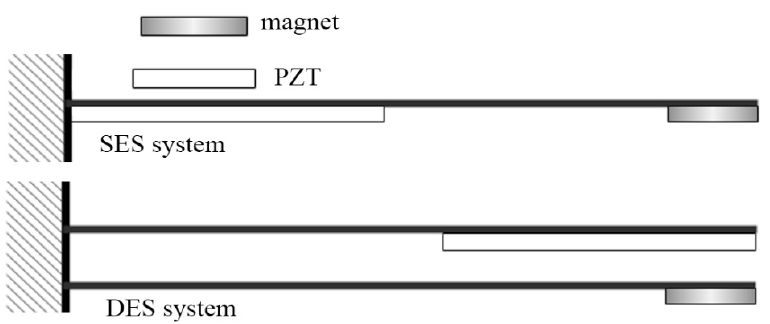
Figure 15. Diagram of ohm-volt and ohm-power, ( a ) ohm-volt diagram, and ( b ) ohm-power diagram.